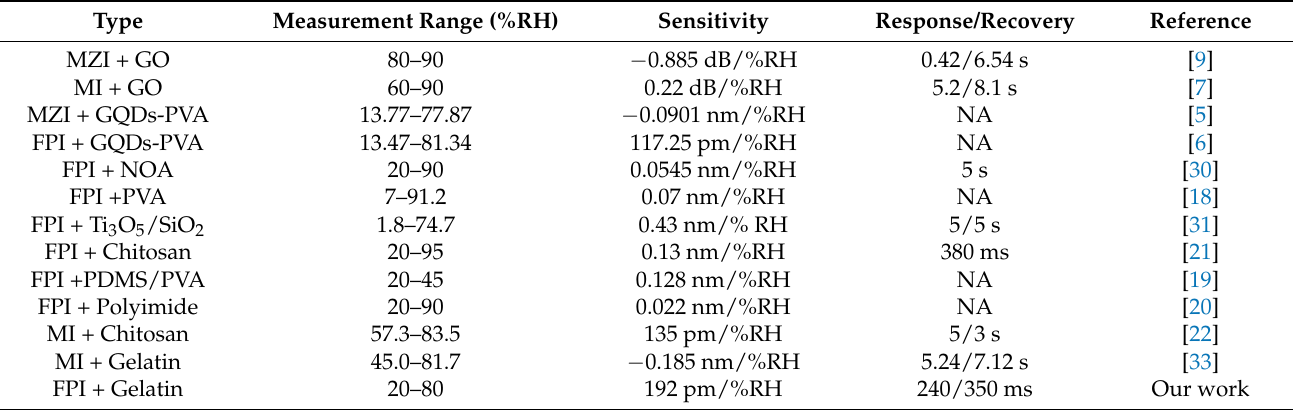
Figure 10. Variation in the FBG sensor’s wavelength with temperature.